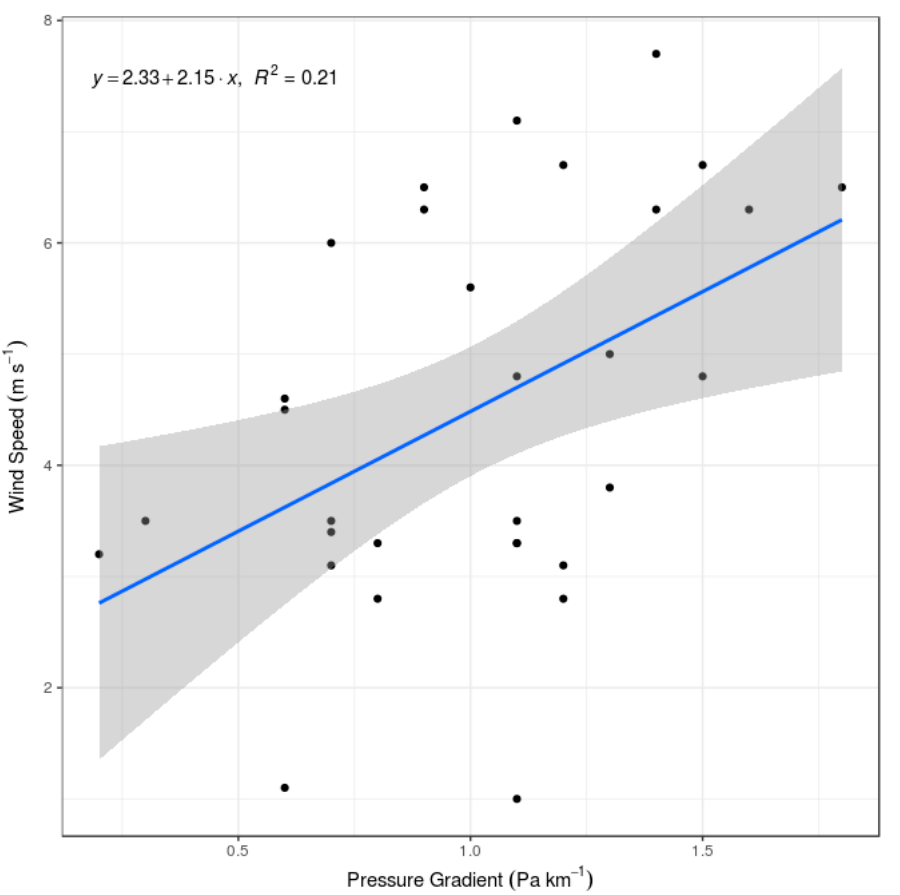
Figure 3. Relationship between the mean sea level pressure gradient at 0600 LT and wind speed at sensor NM3 at 0900 LT. Gray shading indicates the 95% confidence interval.